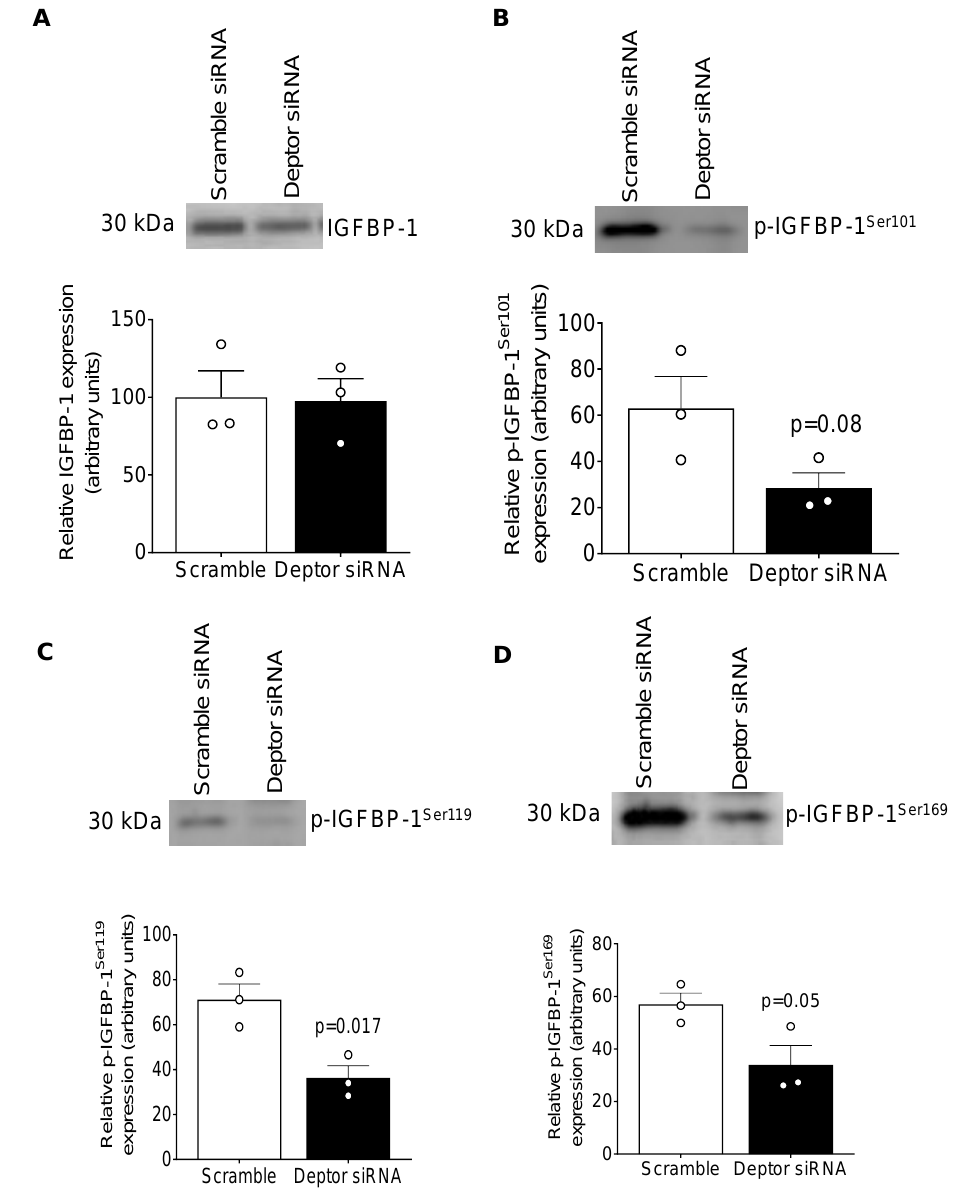
Figure 7. IGFBP-1 secretion and phosphorylation in CM from HepG2 cells treated with CM from PHT cells with the control and DEPTOR siRNA. Equal aliquots of CM from HepG2 cells (7 µ L) treated with CM from PHT cells with the control or DEPTOR siRNA (activates mTOR signaling) were loaded on 1-D gels for a Western blot using anti-human IGFBP-1 monoclonal antibody (mAb 6303) ( A ); 40 µ L of cell media loaded for pS101 ( B ), pS119 ( C ), and pS169 ( D ). Samples were normalized to non-targeting siRNA control, and data were represented as Mean + SEM in bar figures and analyzed with unpaired t -test; p < 0.05 was considered